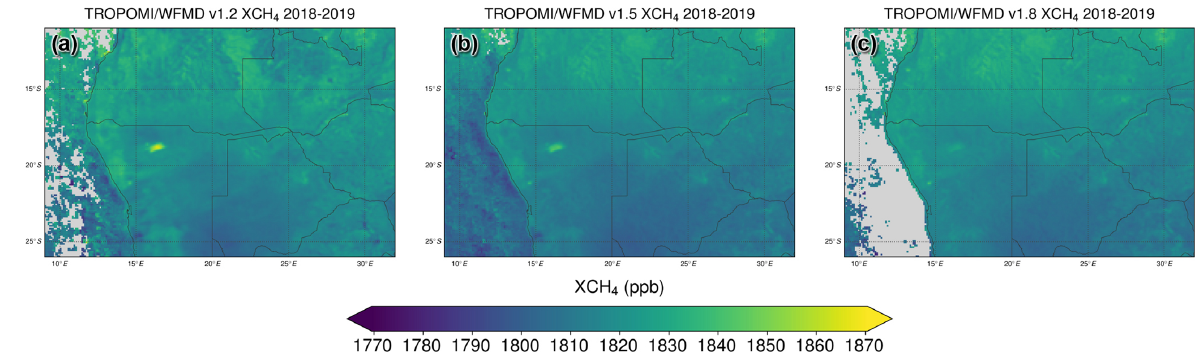
Figure 3. Comparison of the XCH 4 distribution over southern Africa for (a) v1.2, (b) v1.5 (both using a quadratic polynomial), and (c) v1.8 using a polynomial of degree 3 instead in the fitting procedure to better account for potential variability of spectral albedo within the fitting window. As a consequence, the enhancement over the Etosha Pan in Namibia is significantly reduced and considered more realistic (see main text for details). The differences in coverage over the ocean are due to the stricter quality filter in v1.8 (see Sect. 3.3). There is already a noticeable improvement from v1.2 to v1.5 due to the improved calibration taking spectral albedo variability at least partially into account by adding the polynomial parameter p 0 as a